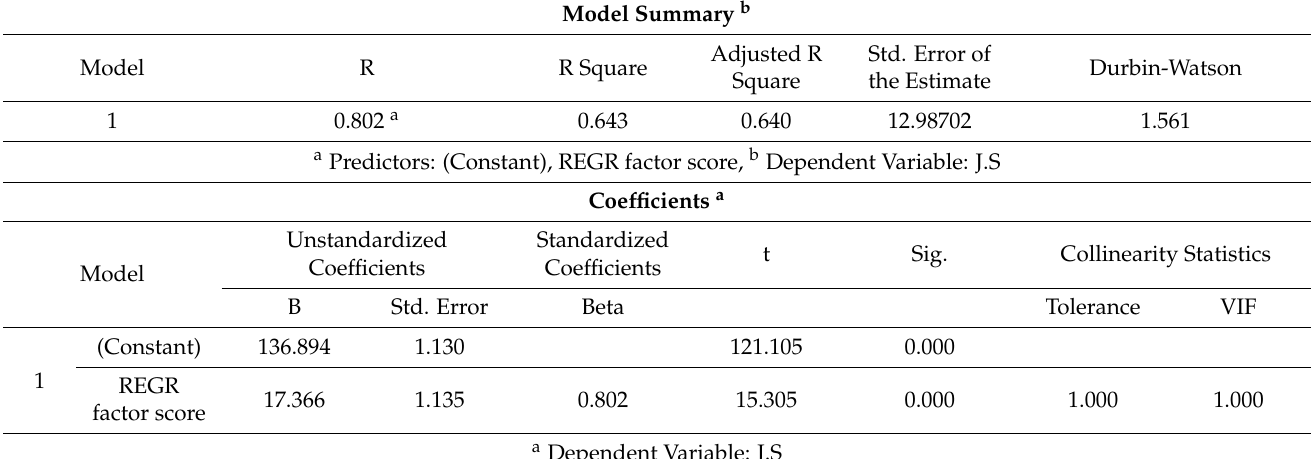
Table 5. Regression analysis of the component on J.S. Model Summary